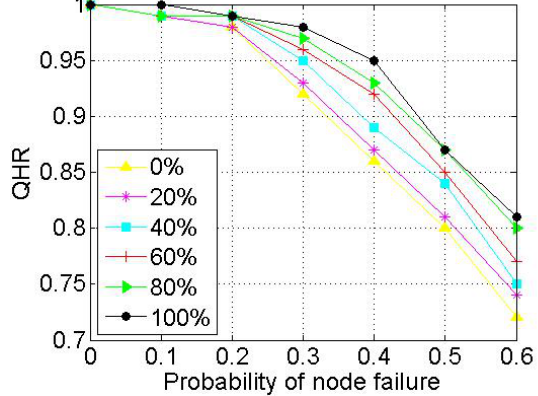
Figure 13. The QHR for SPEQs and probability node failure.